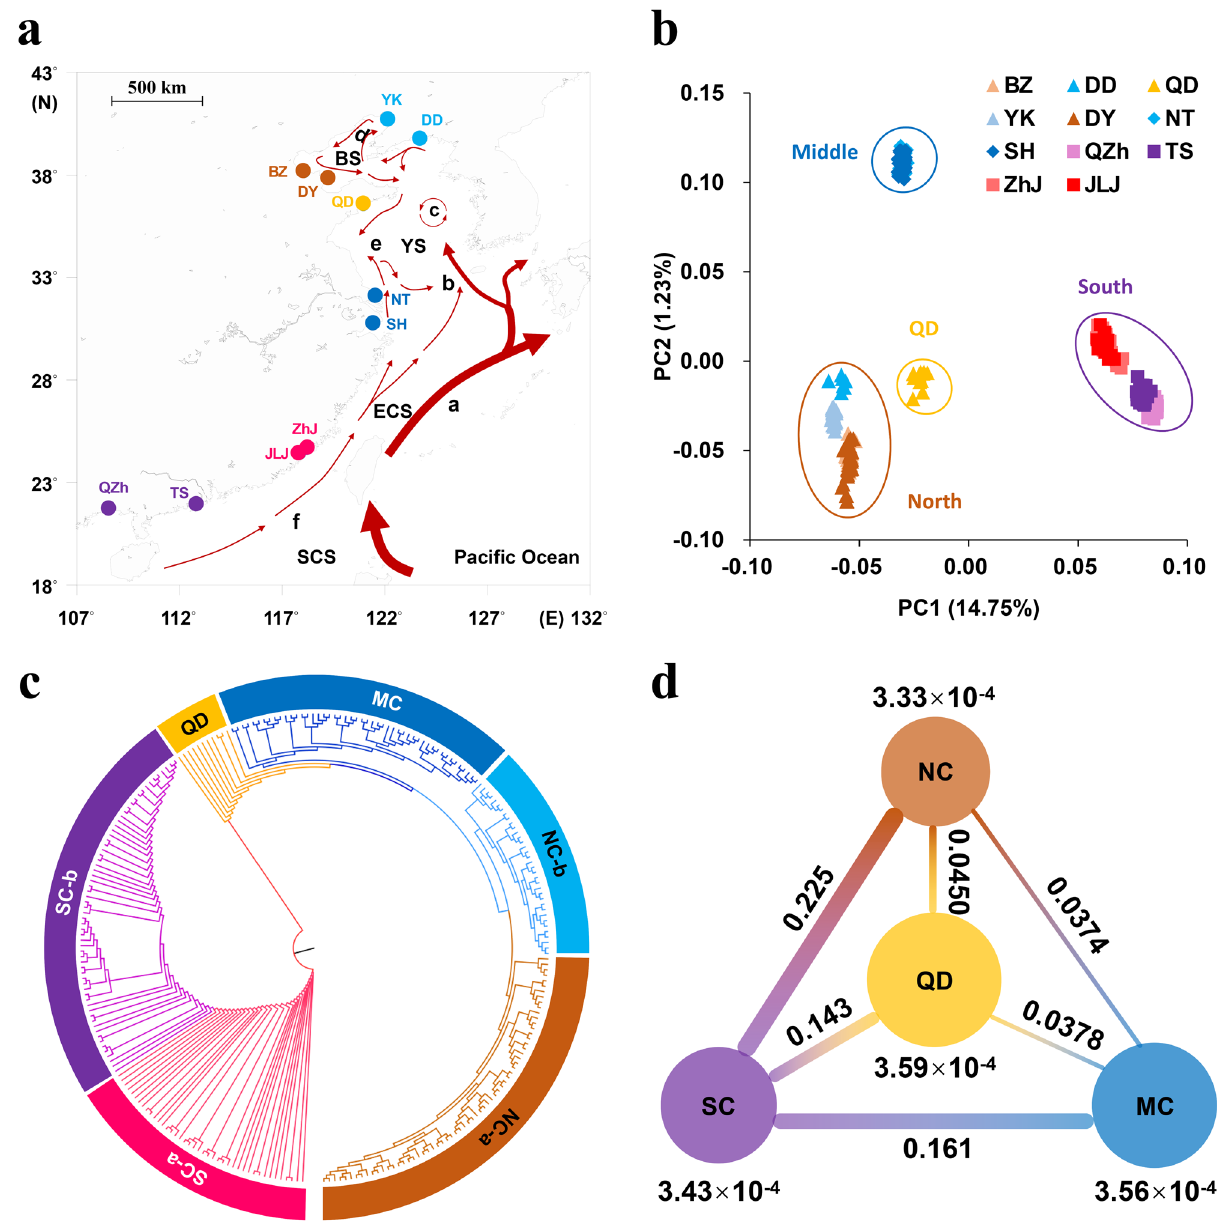
Fig. 2 Geographic distribution and genetic differentiation of the estuarine oyster populations. a Sampling locations of 264 resequenced wild oysters from 11 estuaries along the coast of China. The arrowed curves represent ocean currents in summer. a: Kuroshio Current, b: Yellow Sea Warm Current, c: Yellow Sea Cold Water Mass, d: Bohai Sea Circulation, e: China Coastal Current, f: South China Sea Warm Current. SCS: South China Sea, ECS: East China Sea, YS: Yellow Sea, BS: Bohai Sea. DD: Dandong, YK: Yingkou, BZ: Binzhou, DY: Dongying, QD: Qingdao, NT: Nantong, SH: Shanghai, JLJ: Jiulongjiang, ZhJ: Zhangjiang, TS: Taishan, QZh: Qinzhou. b Plots of principal components 1 and 2 of 264 resequenced oysters based on whole-genome data. c Phylogenetic tree of estuarine oysters inferred from genome-wide SNPs with the Maximum Likelihood (ML) method. NC-a: northern China, including BZ and DY; NC-b: northern China including DD and YK; MC: middle China including NT and SH; SC-a: southern China including JLJ and ZhJ; and SC-b: southern China including TS and QZh. d Nucleotide diversity ( pi , under or above the circles) and genetic divergence ( F ST, between populations) among four